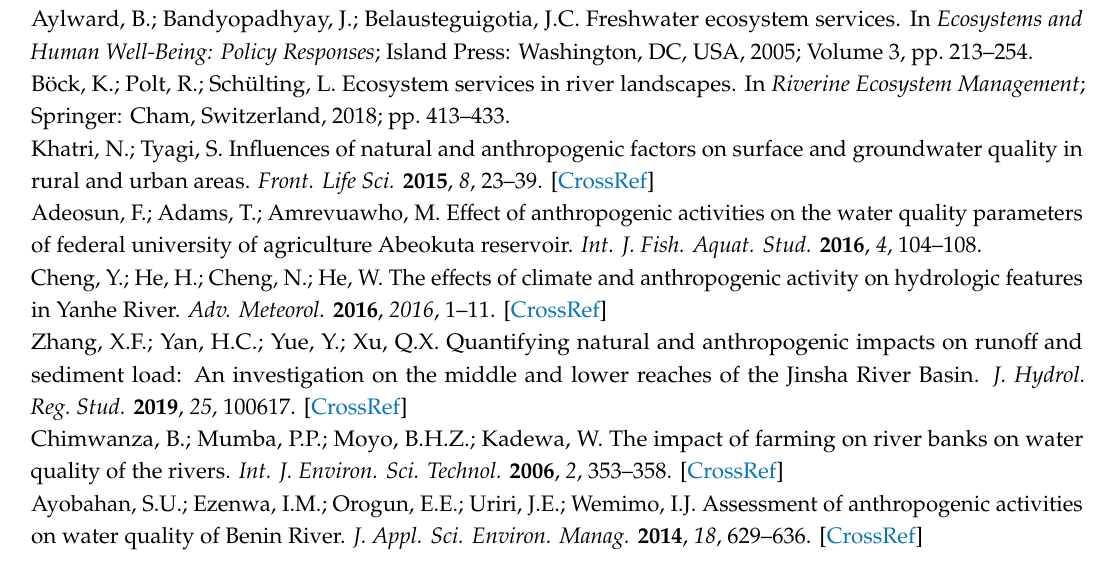
Figure S1: Mean discharge from empirical water balance model. Table S1: Landsat images processed by study